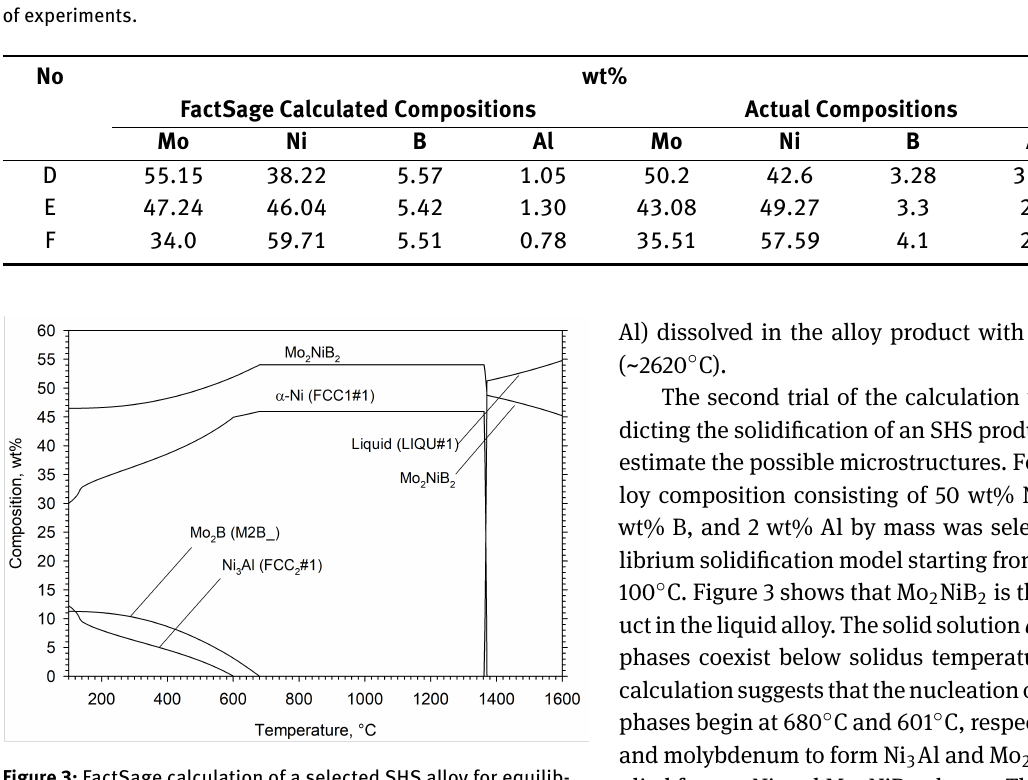
O first reacts with Al 2 3